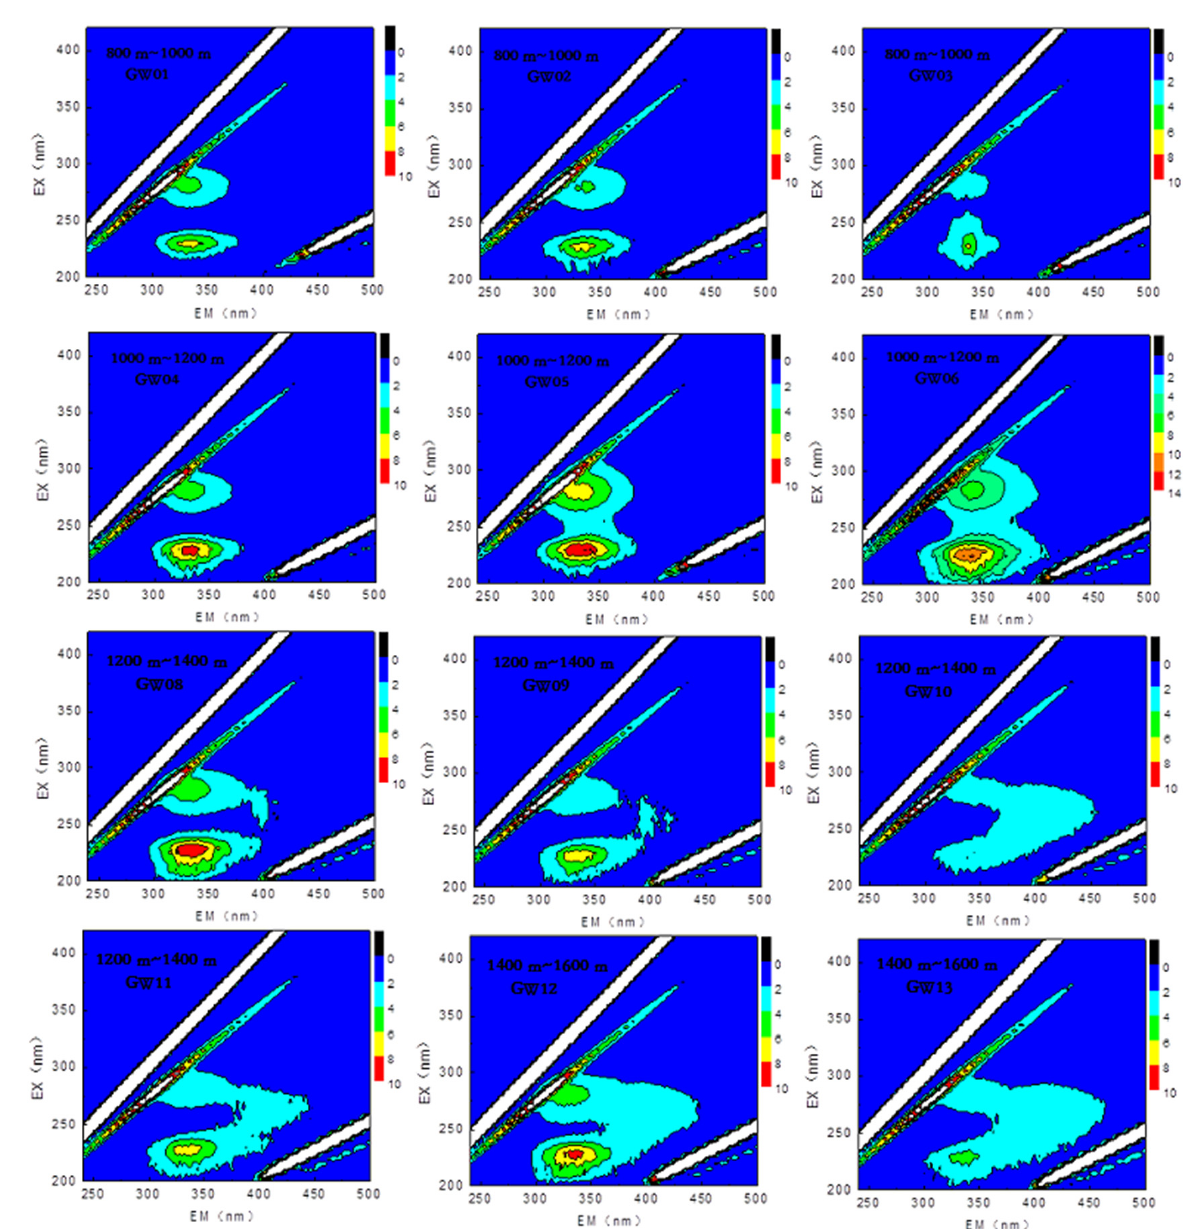
Figure 1. Three-dimensional fluorescence spectra of Dissolved Organic Matter (DOM) in geothermal water from different reservoirs.